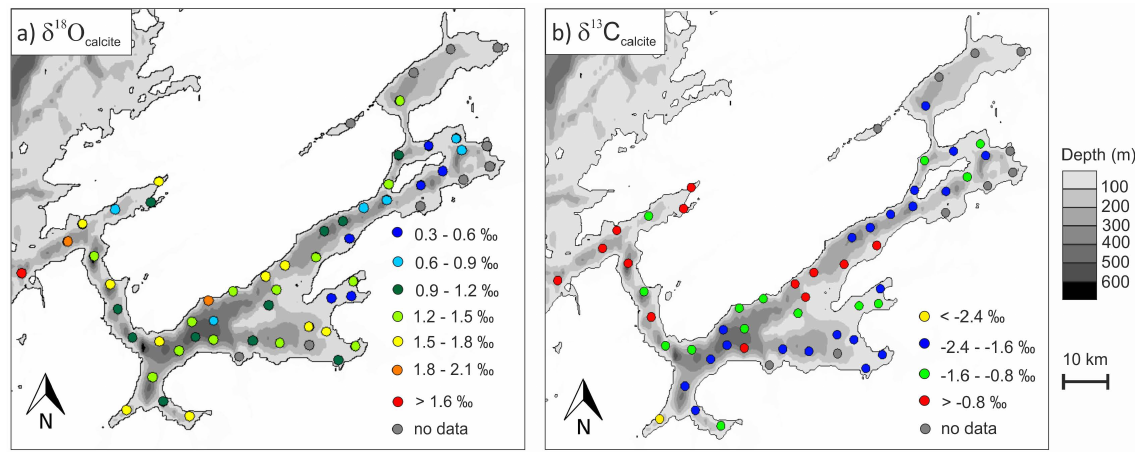
Fig. 3. Benthic foraminiferal ( M. barleeanus ) stable isotope distribution in the Trondheimsfjord: (a) δ 18 O; (b) δ 13 C.